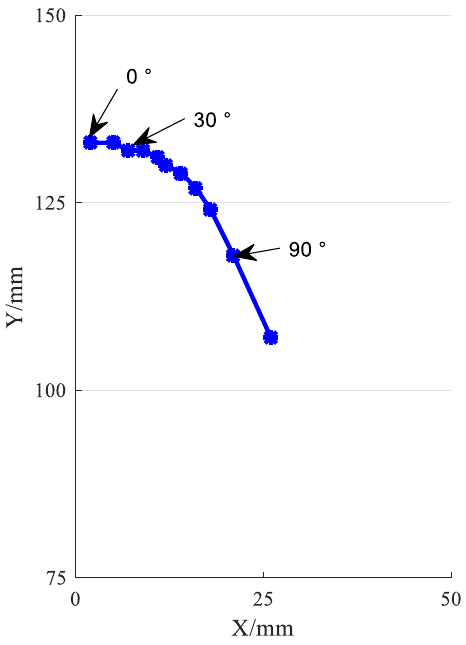
Figure 9. Ideal instant center line of human knee joint (calf fixed).